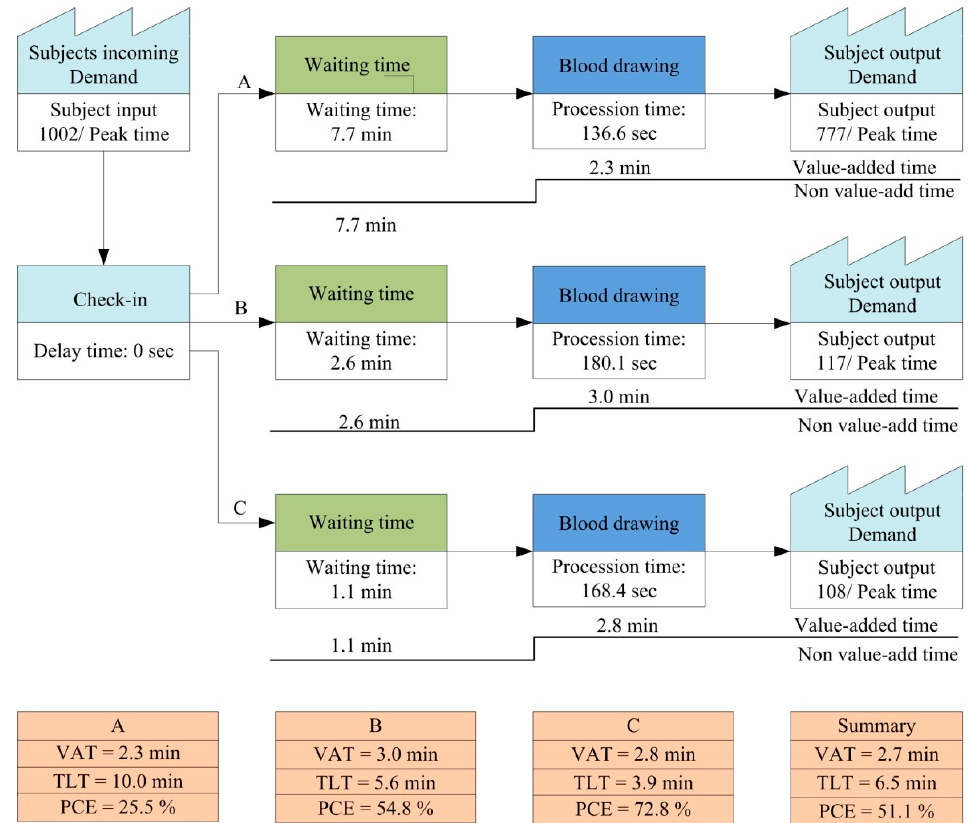
Figure 4. VSM of phlebotomy services: after establishing the ITPS (phase 2). A: general population; B: wheelchair users; C: elderly.